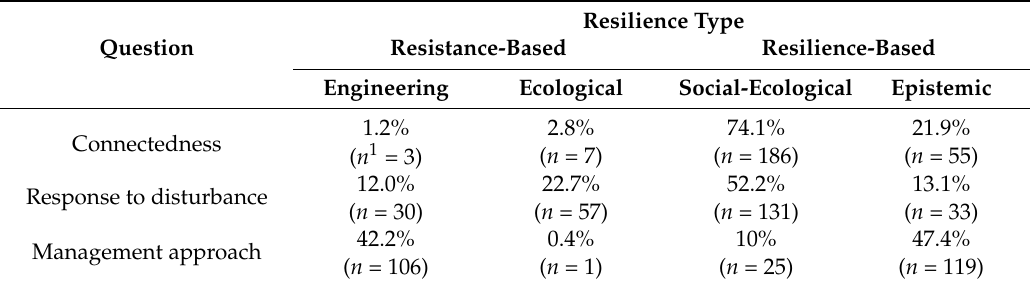
Table 1. Distribution of responses across the internal representations of the